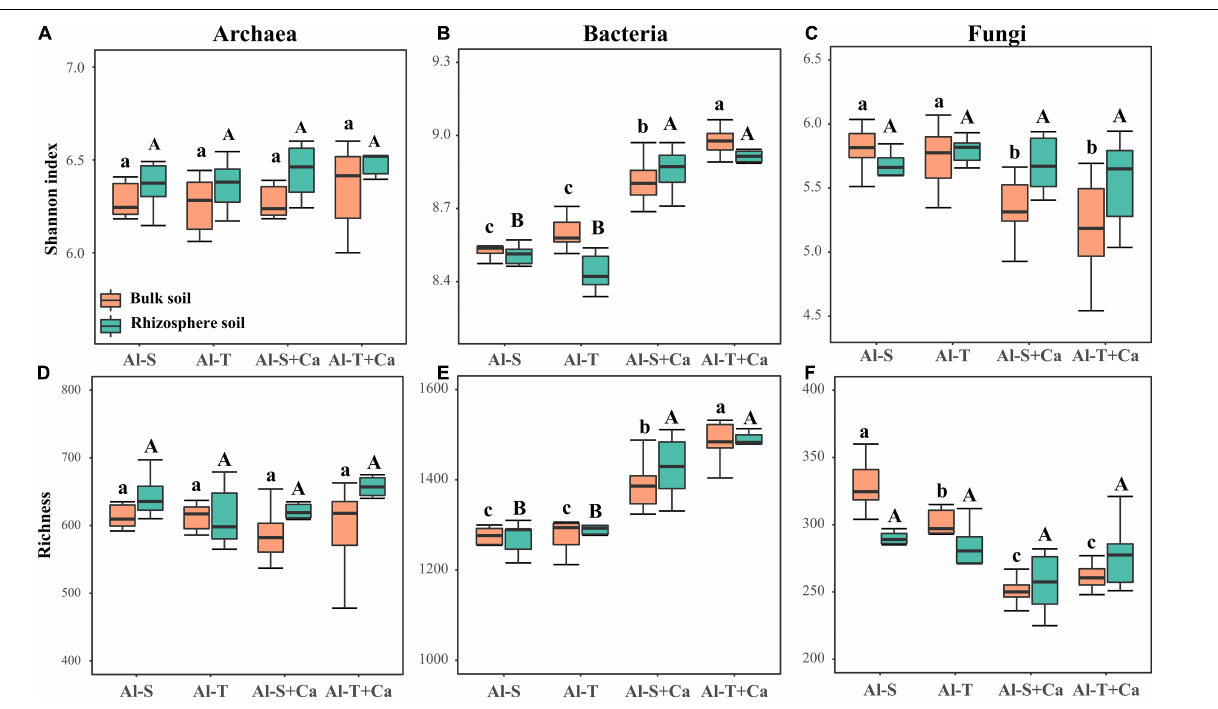
FIGURE 2 | α -diversity of archaea (A,D) , bacteria (B,E) , and fungi (C,F) according to the Shannon and richness indices. Different lowercase and uppercase letters above boxplots indicate significant differences among treatments for the bulk soil and rhizosphere soil ( P < 0.05), respectively. Al-S, Al-sensitive rice; Al-T,